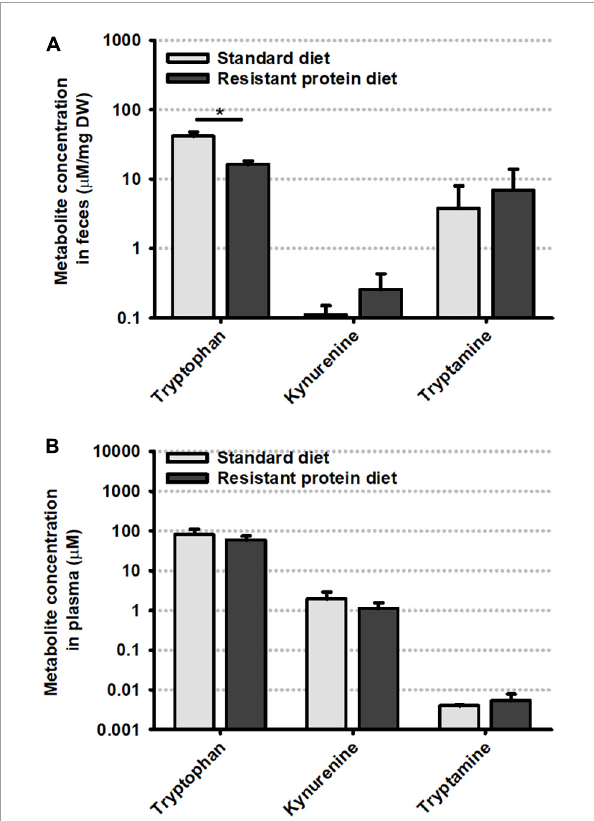
FIGURE4 Comparison of levels of tryptophan and its metabolites, kynurenine and tryptamine in (A) feces and (B) plasma, on day -3. Data represent means and standard deviation ( n = 3). Statistical comparisons were conducted using the non-parametric Mann–Whitney U test with significant differences shown at p < 0.05.